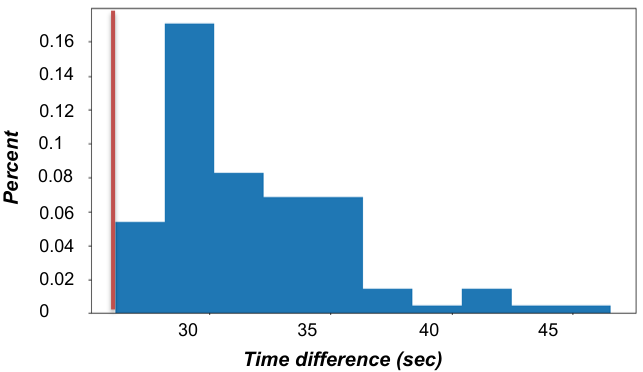
Figure 27. Cost differences histogram. This histogram demonstrates the cost differences between the GA’s solutions and those of the 2-factor approximation method, which are denoted by the red line. Positive values represent a better (lower) solution cost of the GA.